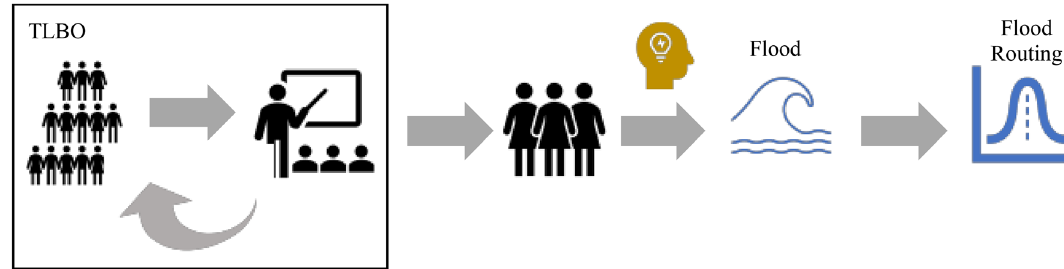
Figure 1. Graphical